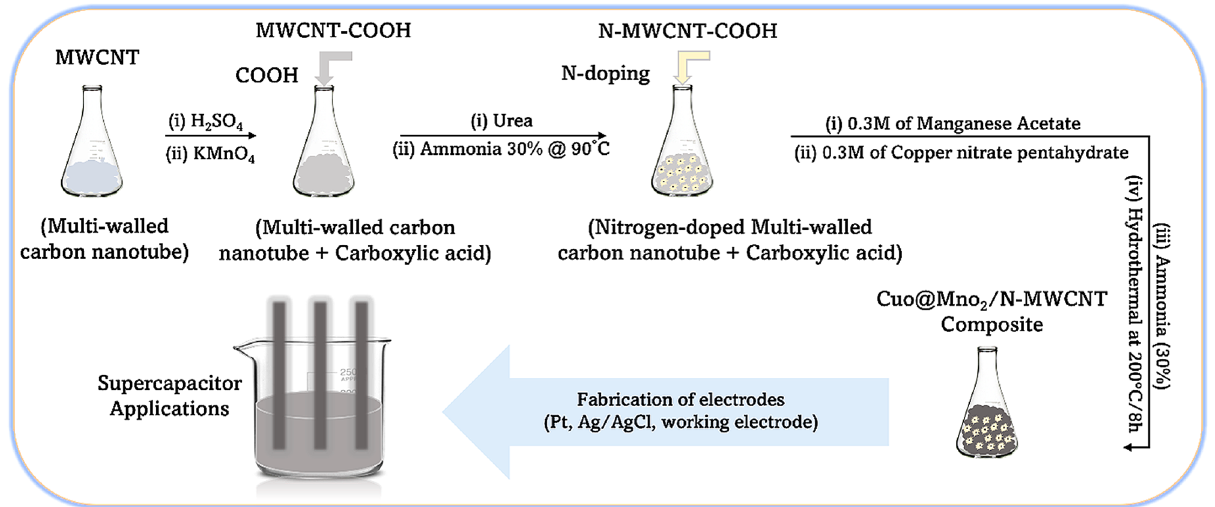
Figure 1. Schematic of the CuO@MnO 2 /N-MWCNT composite synthesis process.